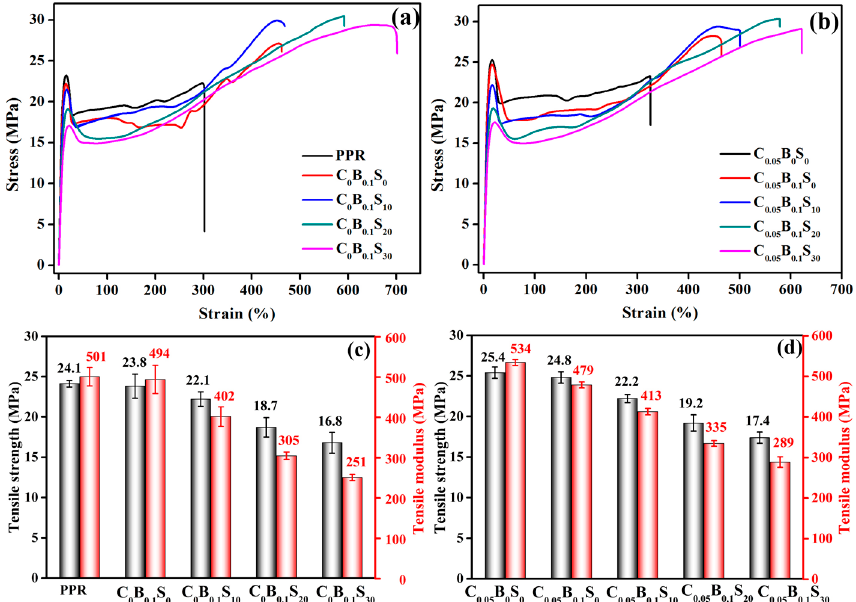
Figure 3. Stress-strain curves ( a , b ), tensile strength ( c ) and tensile modulus ( d ) of PPR and its blends.